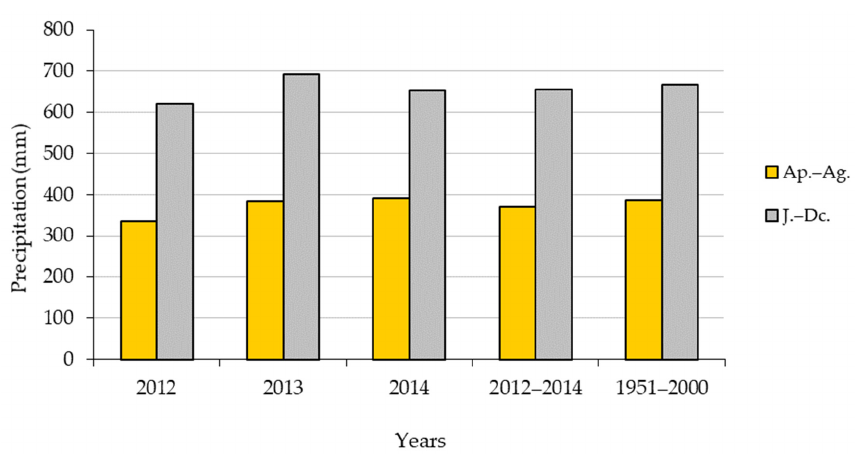
Figure 2. Sum of precipitation (mm) in the vegetative period (April–August) and the years of study 2012–2014 compared to multiyear.